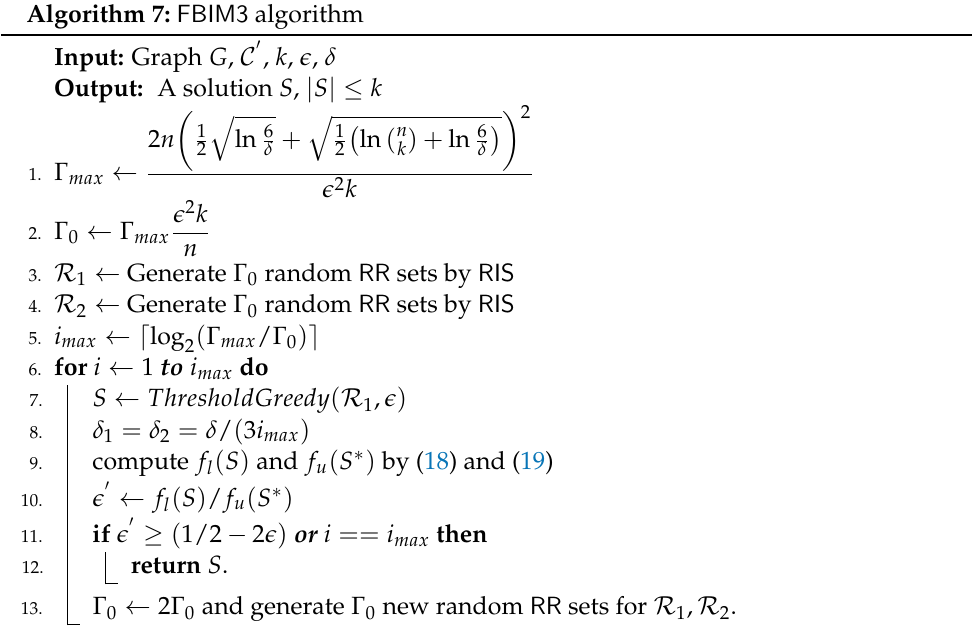
Algorithm 7: FBIM3